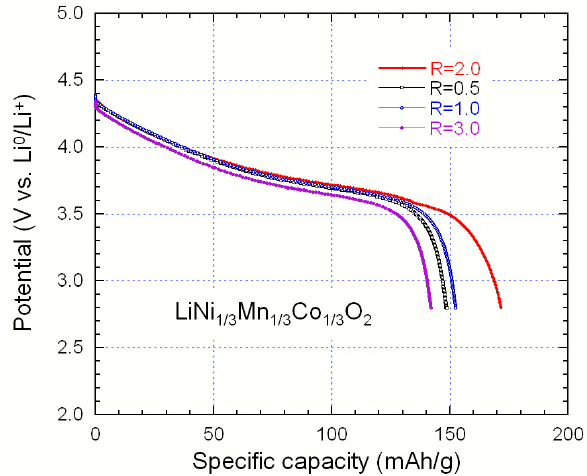
Figure 14. Initial discharge profiles of synthesized NMC sample sintered at 900 °C for 15 h, synthesized with chelate to metal ion ratio at 0.5 ≤ R ≤ 3.0.